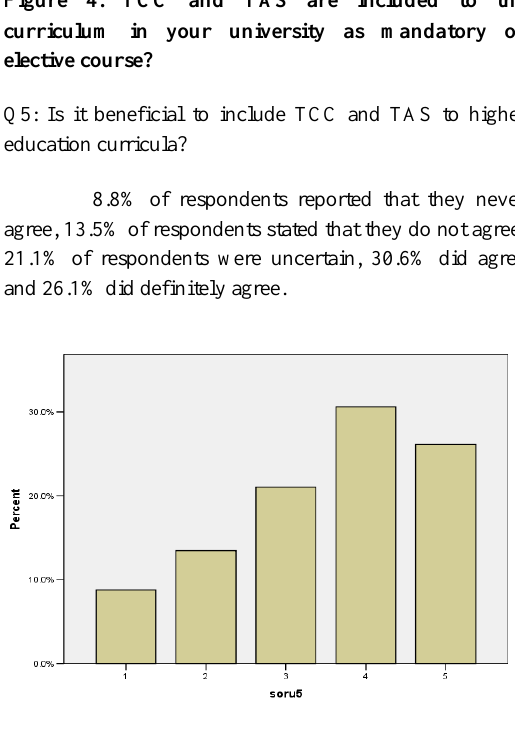
Figure 4. TCC and TAS are included to the curriculum in your university as mandatory or